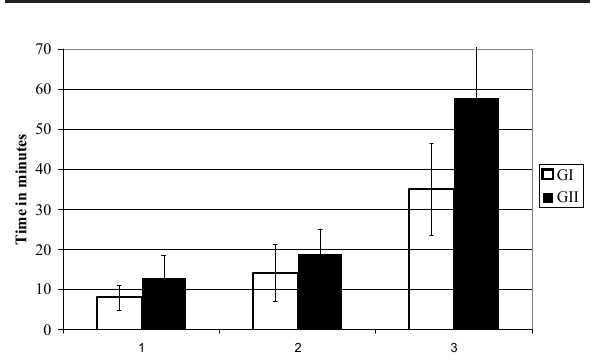
FIGURE 6 - Physiological behavior of anesthetic volume of propofol(ml) in G1 and G2